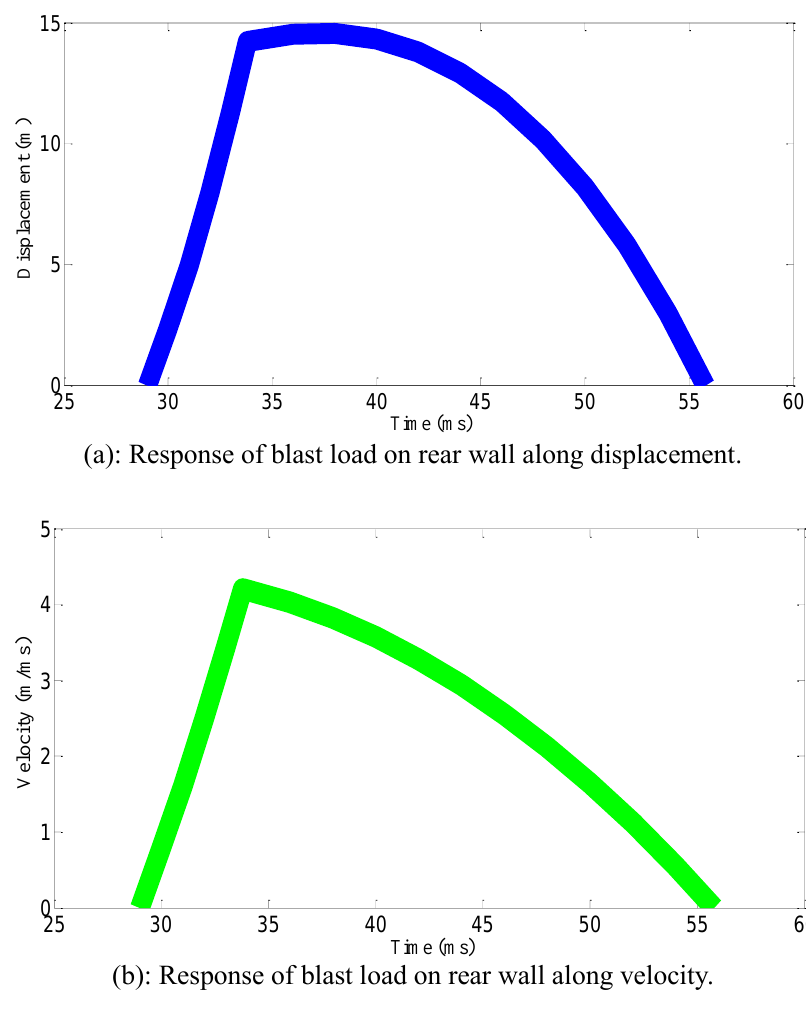
(b): Response of blast load on rear wall along